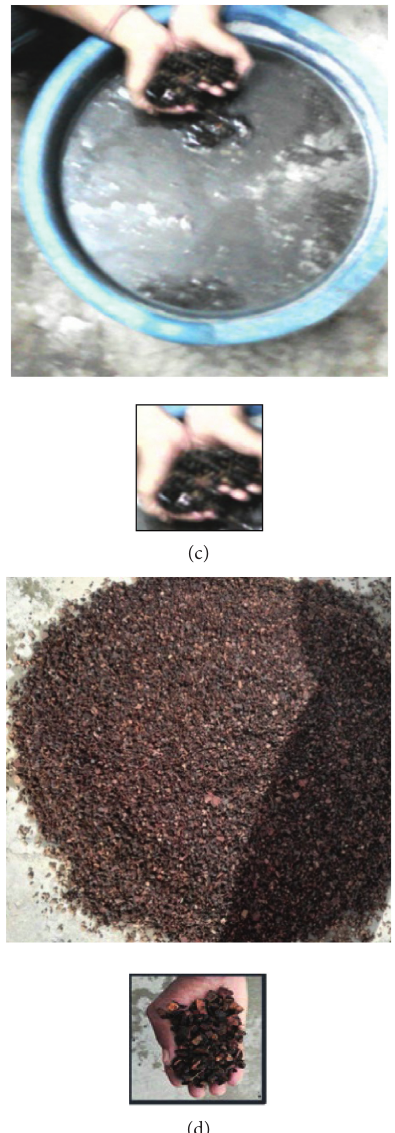
Figure 1: Processing of CS (SSD condition). (a) Preparation of raw coconut shell aggregate. (b) Raw crushed CS 12.5 mm. (c) CS after immersion in water for 24h. (d) CS in SSD